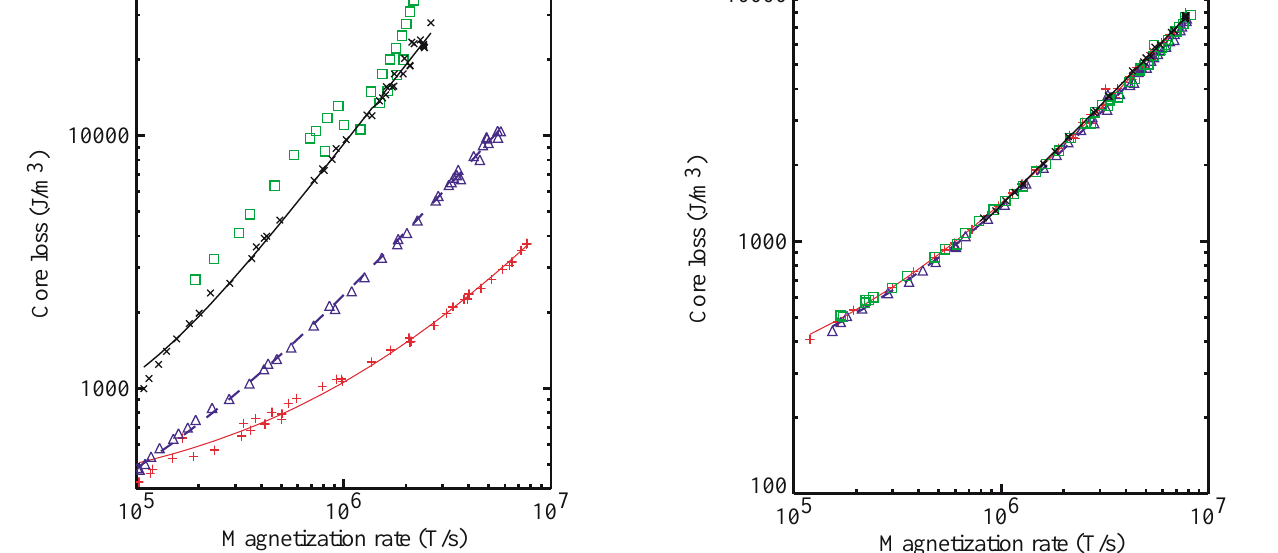
FIG. 24. (Color) Core loss versus magnetization rate for four 6% silicon steel cores. The data are all at a flux swing of 2.40 T: ( 3 , black) Si6-4; ( (cid:1) , green) Si6-3; ( (cid:3) , blue) Si6-2; and ( 1 , red, solid line) Si6-1.